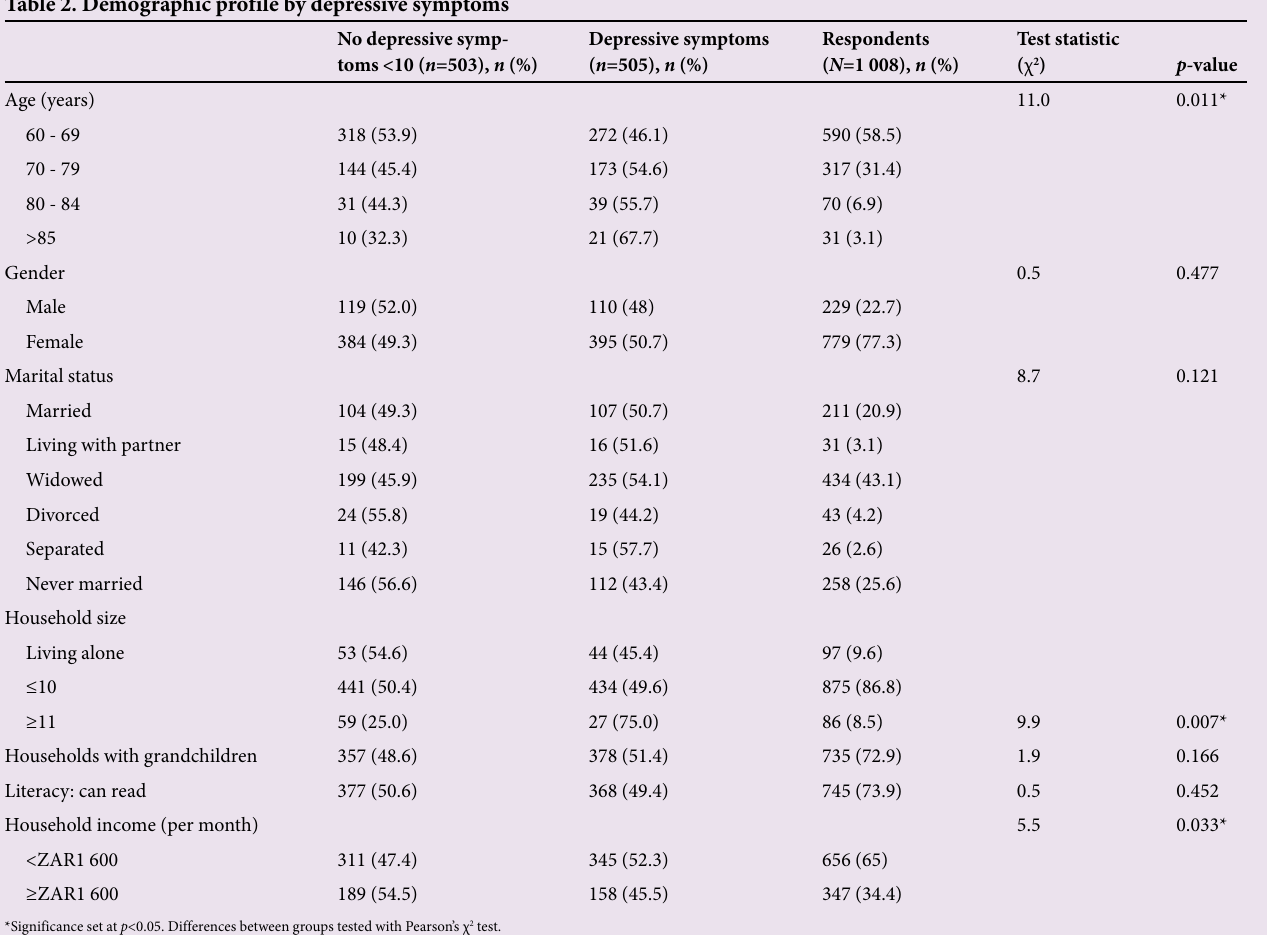
Table 2. Demographic profile by depressive symptoms